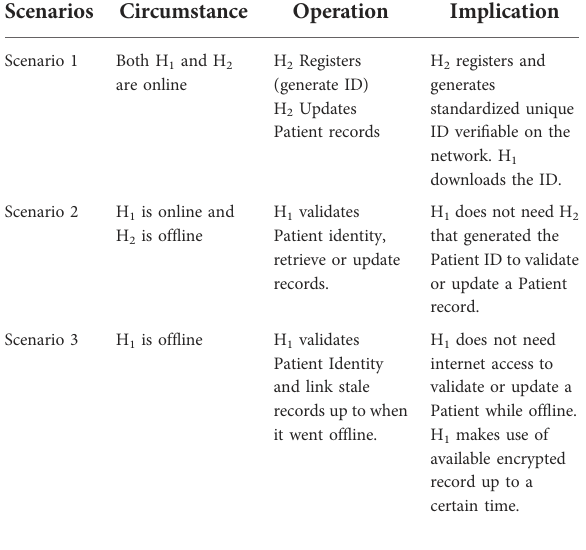
TABLE 2 Scenarios and implications for patient veri fi cation and records linkage.